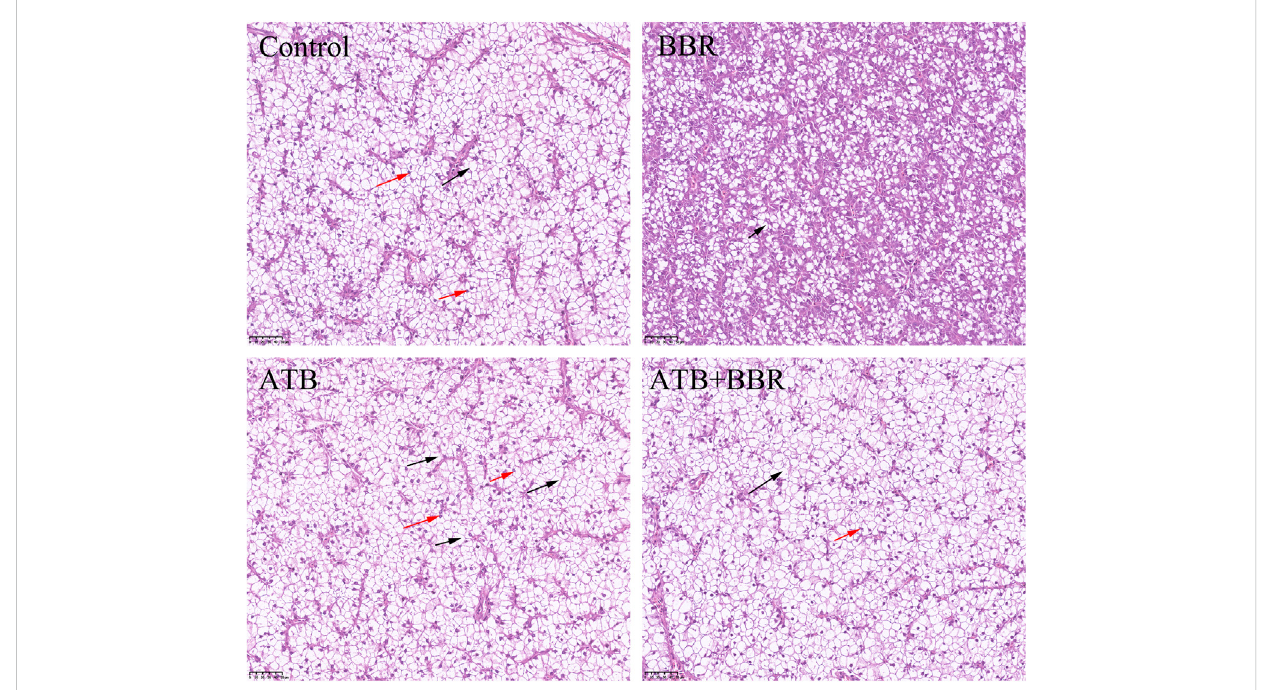
FIGURE 4 Hematoxylinandeosinstainingoflargemouthbassliver(×10).Theredarrowsinthepicturerepresentthenucleuspushedtotheedgeofthecell;the black arrows represent the disappearance of the cell nucleus and cytoplasmic vacuolization. BBR, berberine; ATB, antibiotics.